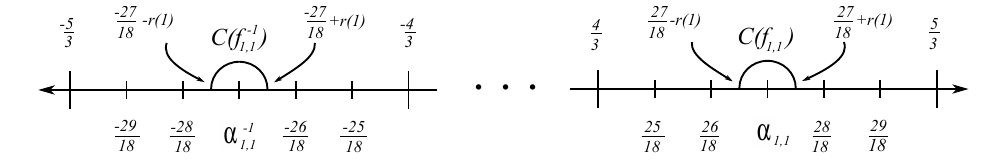
(cid:0) 1 (cid:1) (see Figure 12). 10 3·6·2 m